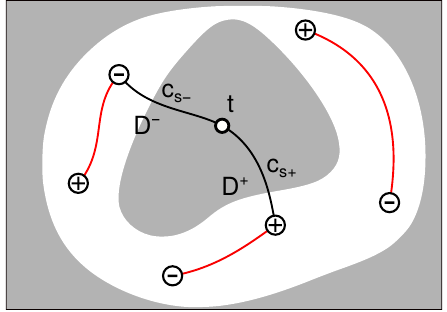
Figure 1. The definition of the positive continuity distance ( D + ) and the negative continuity distance ( D − ) at point t . The red lines connecting dual residues represent the discontinuity boundaries, and the black lines refer to the the shortest paths to the residues. The full (sum) continuity distance ( D ) in the gray areas is higher than a given